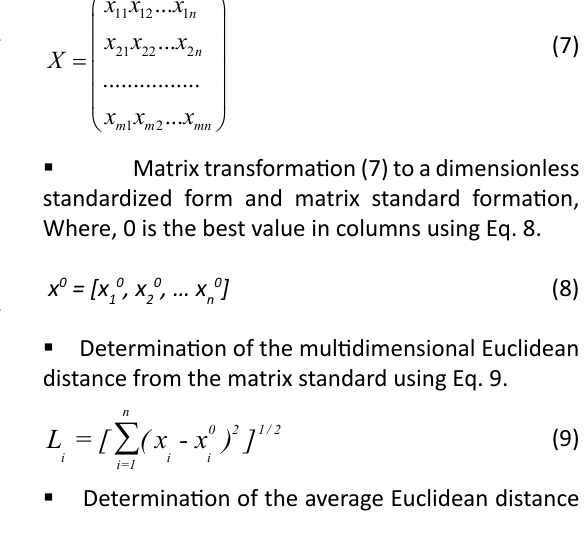
 Matrix formation of significant indicators identified at the first stage of factor analysis (highlighted in red in the STATISTICA listing). The initial matrix has the following form using Eq. 7.